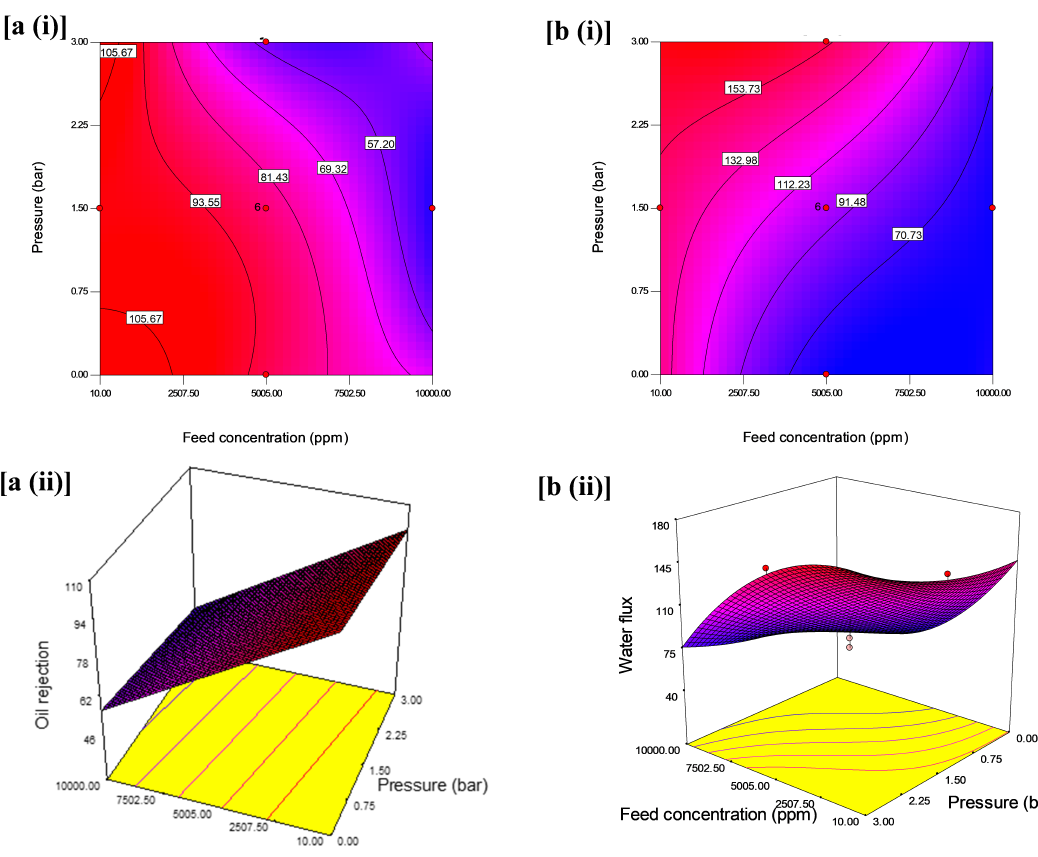
Figure 6. ( i ) Contour plot and ( ii ) 3D surface graph: ( a ) for the interaction effect of feed concentration and pressure on oil rejection (%) and ( b ) for the interaction effect of feed concentration and pressure on water flux (L/m 2 ·